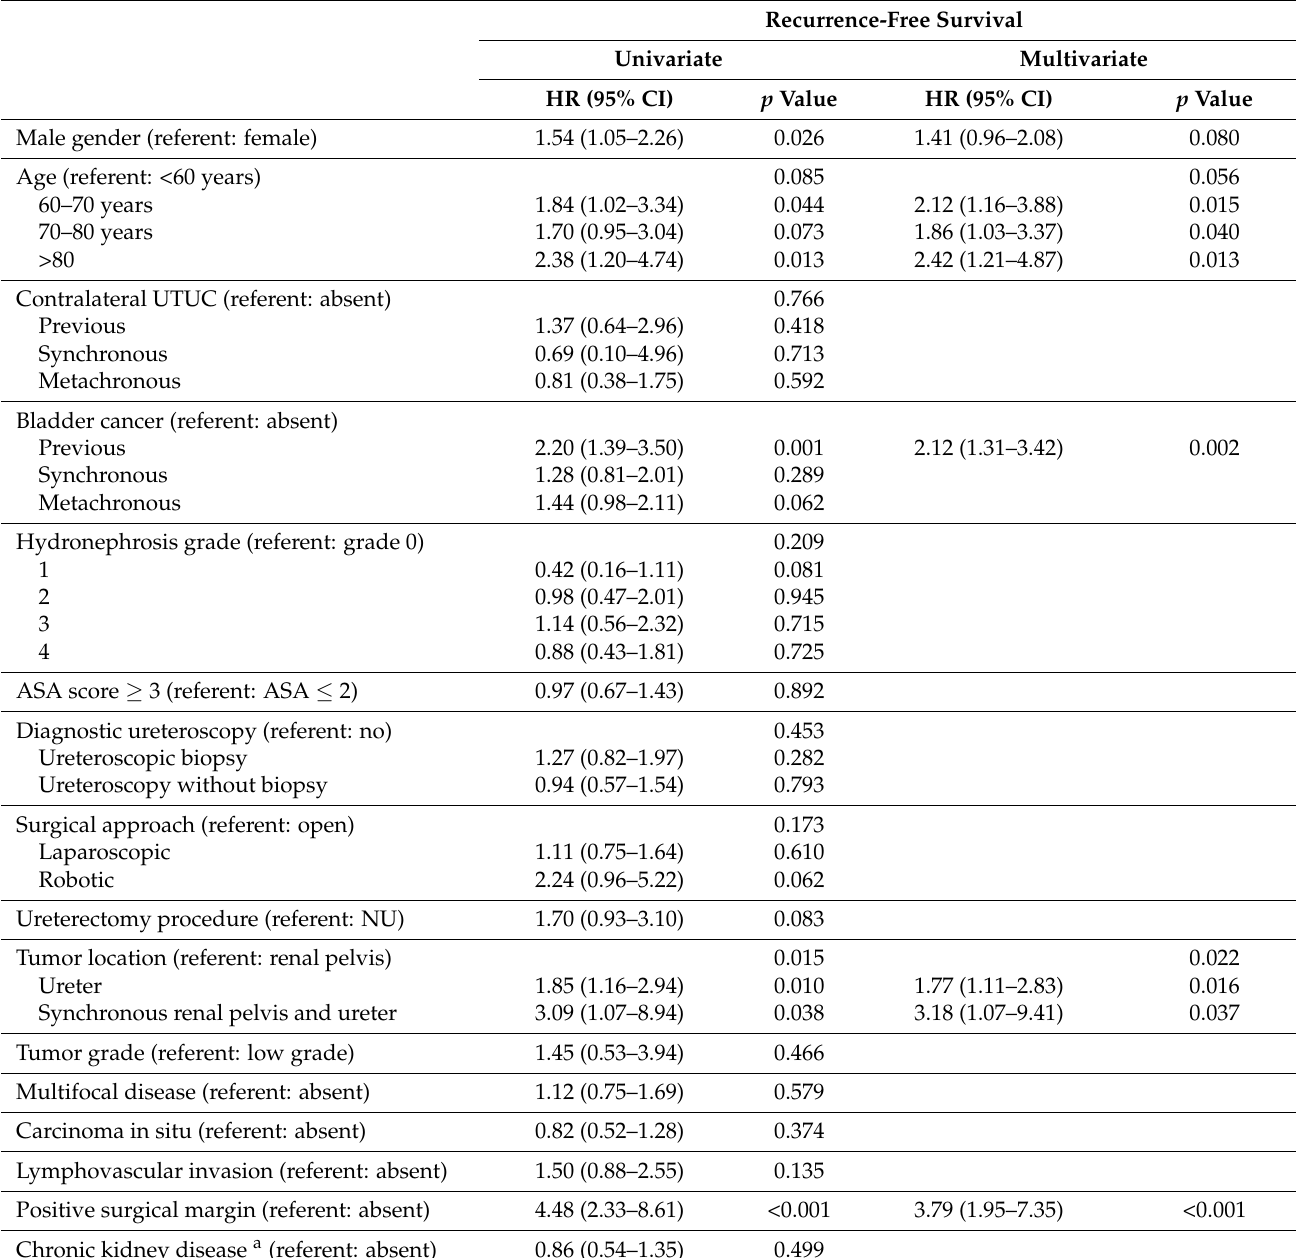
Table 2. Univariate and multivariate analysis predicting prognostic factors for recurrence-free survival in the patients with pT2 UTUC after radical surgery. Recurrence-Free Survival Univariate Multivariate HR (95%